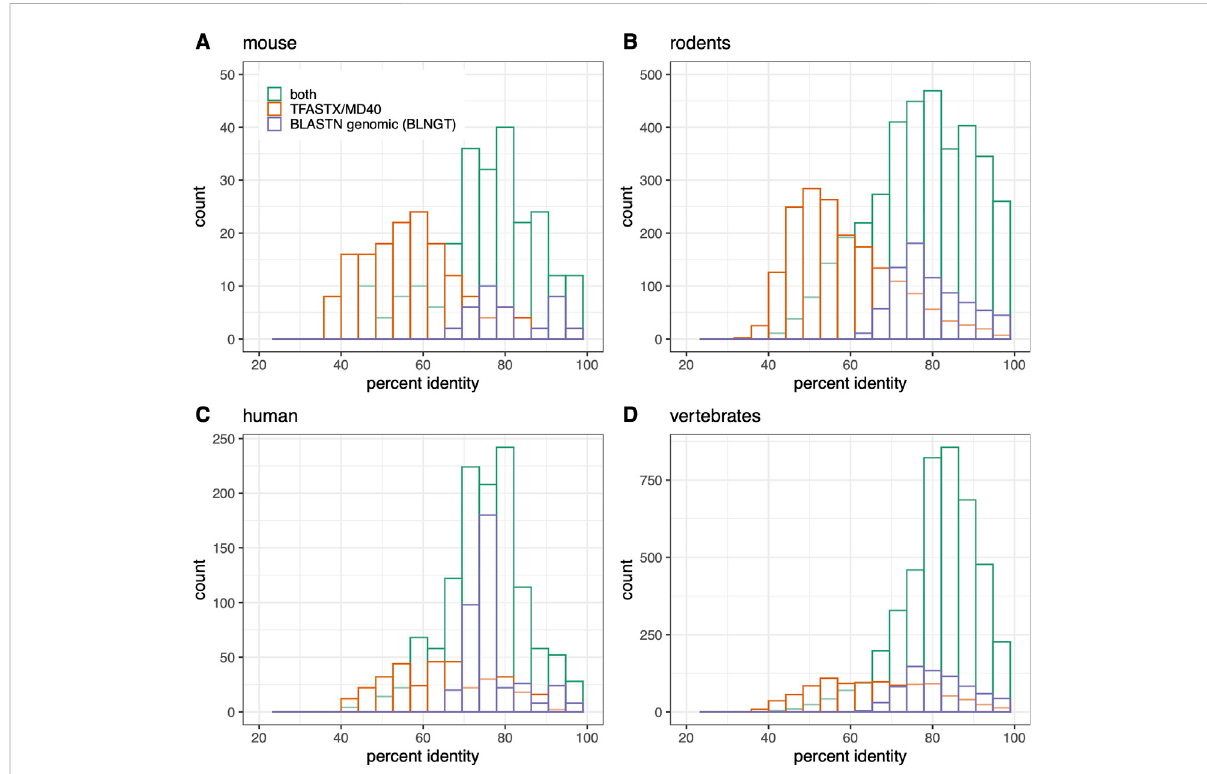
FIGURE 3 Numt counts (MD40BG) vs percent identity separated by TFASTX/MD40 only (orange), BLASTN “ -task blastn ” whole mitochondrial genome only (BLNGT, purple), or both methods (green). (A) Mus musculus ; (B) rodent RefSeq genomes used in Figure 1; (C) Homo sapiens ; (D) vertebrate RefSeqgenomes.Thepercentidentitiesarecomparedineachpanelfor1)TFASTX(orange):numtsfoundonlywithcodingsequencequeriesTFASTX protein:translated-DNAwiththeMD40scoringmatrix;2)BLASTN(purple):numtsfoundonlywithwholemtDNAgenomes-BLASTNDNA:DNA with “ -task blastn ” option that includes numts from non-coding portions of the genome; 3) numts found with both methods (TFASTX and BLASTN,